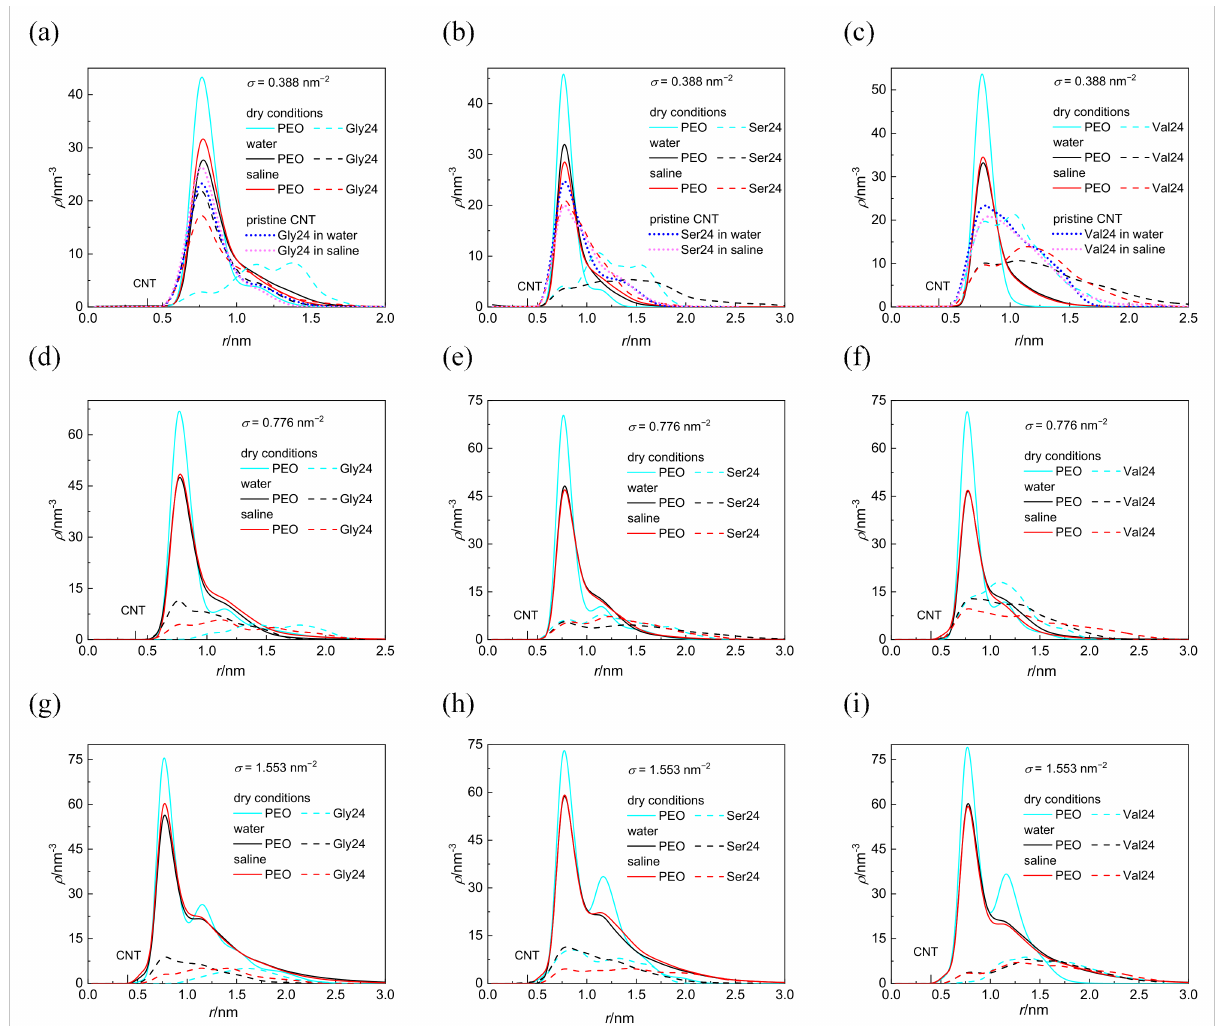
Figure 2. Cylindrical density distribution of the PEO chains grafted at σ = 0.388 nm − 2 ( a – c ), 0.776 nm − 2 ( d – f ), and 1.553 nm − 2 ( g – i ) and polyglycine ( a , d , g ), polyserine ( b , e , h ), and